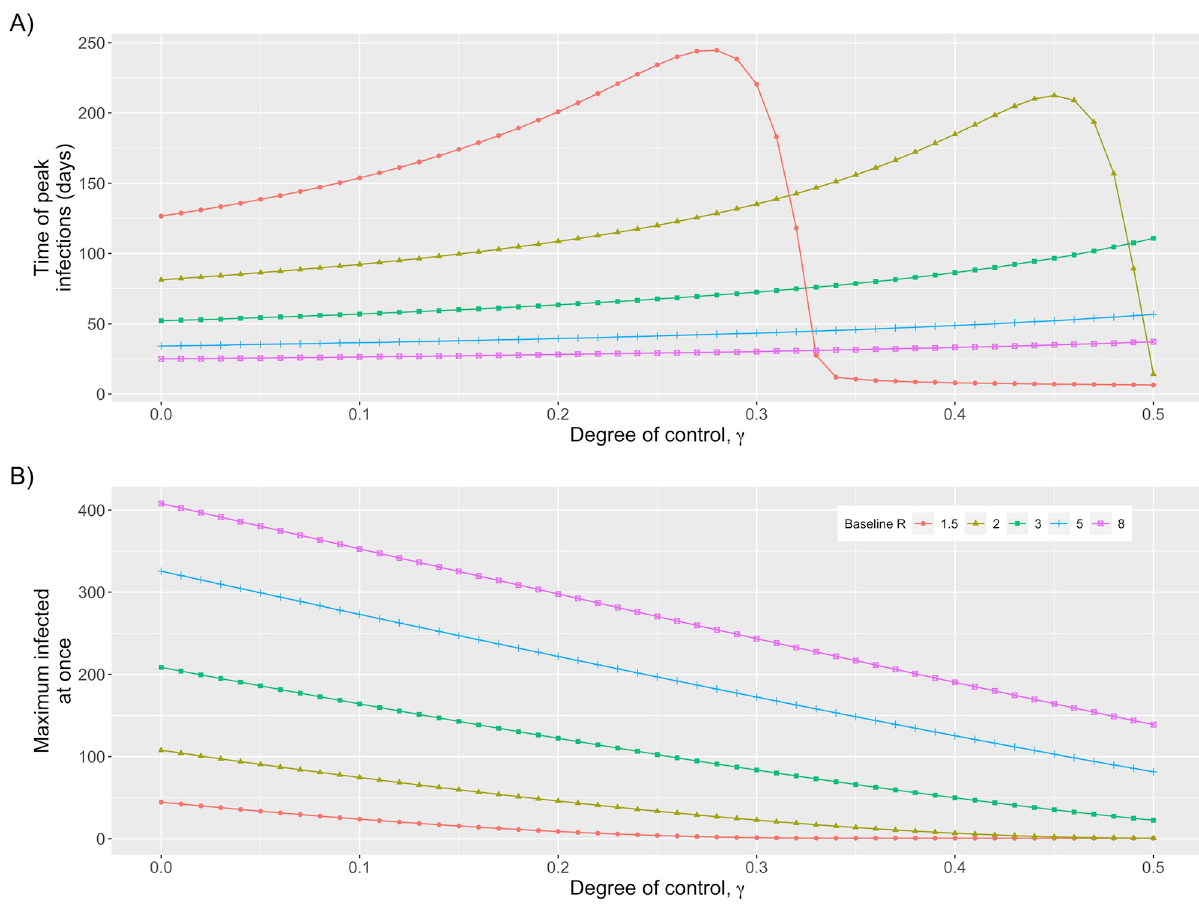
Fig 4. Peak of outbreak. A) Time until peak in the number of infectious individuals, measured from the start of an outbreak B) Maximum number of residents who are infectious at once. For both panels density-dependent control is assumed (i.e. Θ N = Θ R = 1). Colors and shapes represent different values of the baseline reproduction number, R , as indicated by the legend. Parameter values are the same as for S4 Fig. For lower values of baseline R B the timing of the peak in the number of infectious individuals abruptly decreases when the control factor is sufficiently high because the effective reproduction number becomes less than one and thus no significant peak in infectious cases